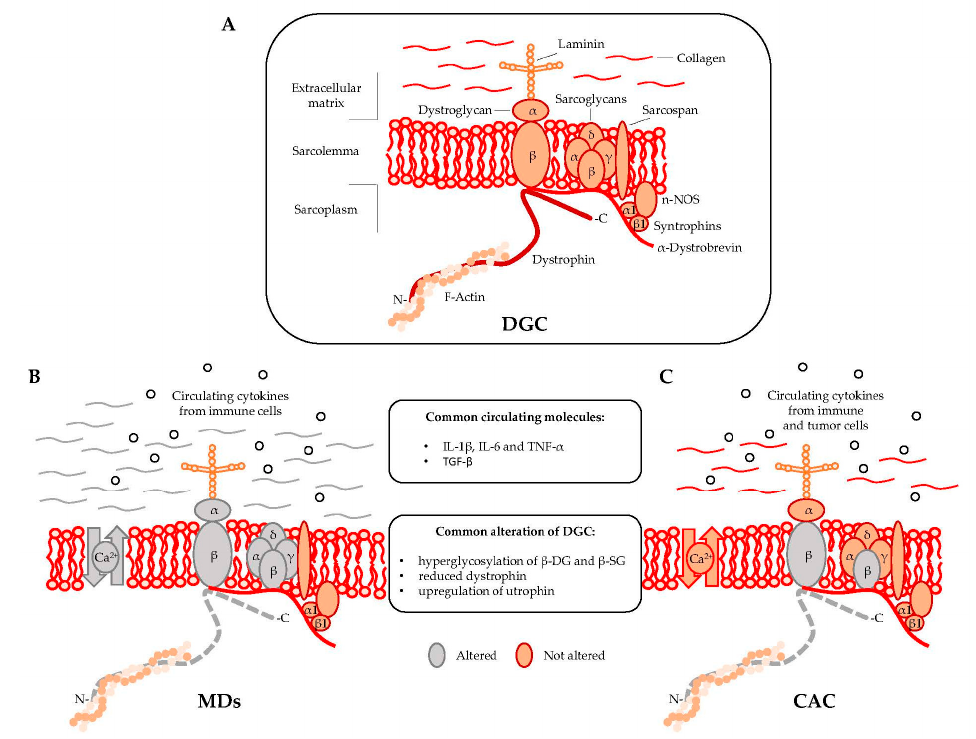
Figure 1. Muscular dystrophies (MDs) and cancer-associated cachexia (CAC) share peculiar abnormalities of the dystrophin glycoprotein complex (DCG). ( A ) DGC Model; ( B ) DGC in MDs is characterized by specific mutations (grey color) in α , β , γ , and δ subunit of the sarcoglycan complex (in sarcoglycanopathies), hyperglycosylation of α -dystroglycan ( α -DG), β -dystroglycan ( β -DG) and β -sarcoglycan ( β -SG), reduced expression of dystrophin, altered intracellular influx of calcium, and abundant deposition of collagen in the extracellular matrix; ( C ) DGC in CAC is characterized by hyperglycosylation of β -dystroglycan ( β -DG) and β -sarcoglycan ( β -SG) and reduced content of dystrophin.